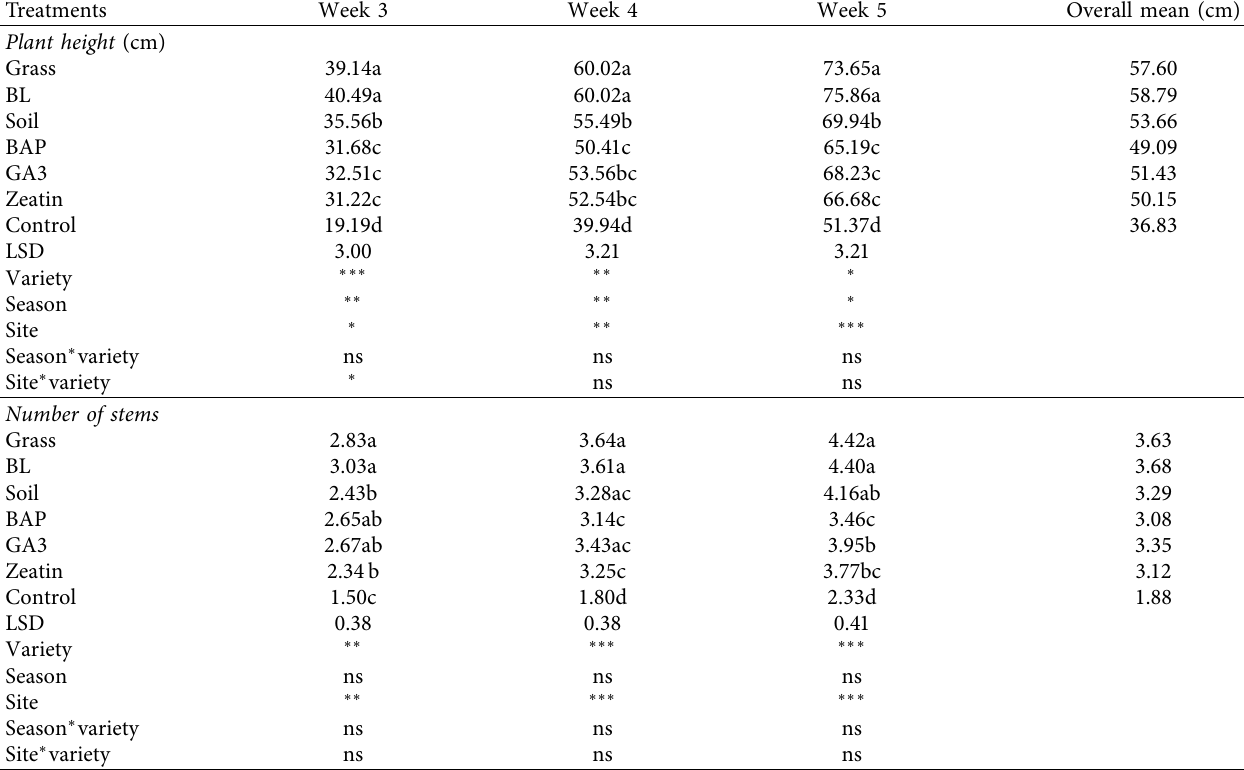
Table 9: Means effects of plant growth regulators and natural materials on plant height and number of stems at different weeks after planting.